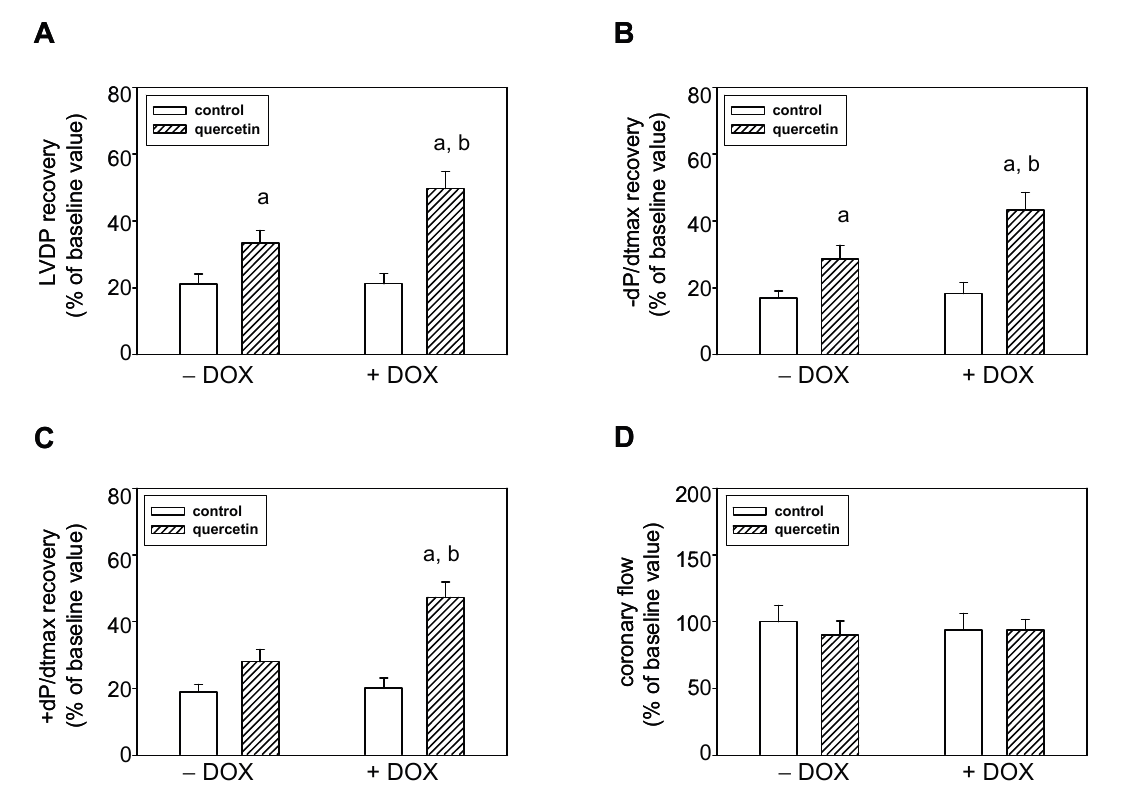
Figure 6. Effects of quercetin on ischemic tolerance of hearts isolated from normal and doxorubicin-treated rats. ( A ) Postischemic recovery of the left ventricular developed pressure LVDP; ( B ) Postischemic recovery of the maximal rate of pressure development +(dP/dt) max ; ( C ) Postischemic recovery of the maximal rates of pressure fall − (dP/dt) max ; ( D ) Postischemic recovery of the coronary flow. The recovery of parameters was determined after 30 min lasting global ischemia followed by a 40-min reperfusion. The recovery of parameters was expressed as a percentage of pre-ischemic baseline values. Each bar represents mean ± S.E.M. of eight independent measurements. a p < 0.05 vs. control saline-treated ( − DOX) rats; b p < 0.05 vs. DOX-treated (+DOX)